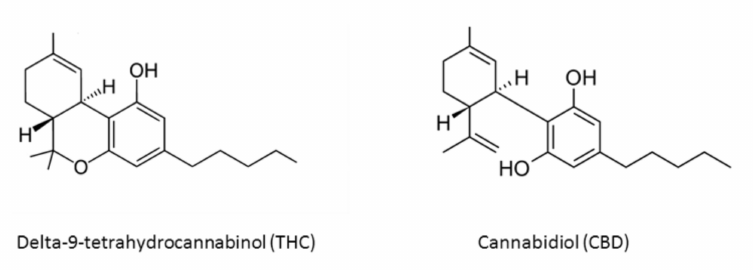
Figure 1. Chemical structures of main Cannabis sativa active